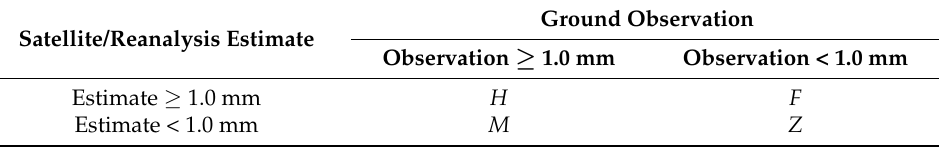
Table 2. Contingency table for the ground observations and the Satellite/reanalysis estimate with a threshold of 1.0